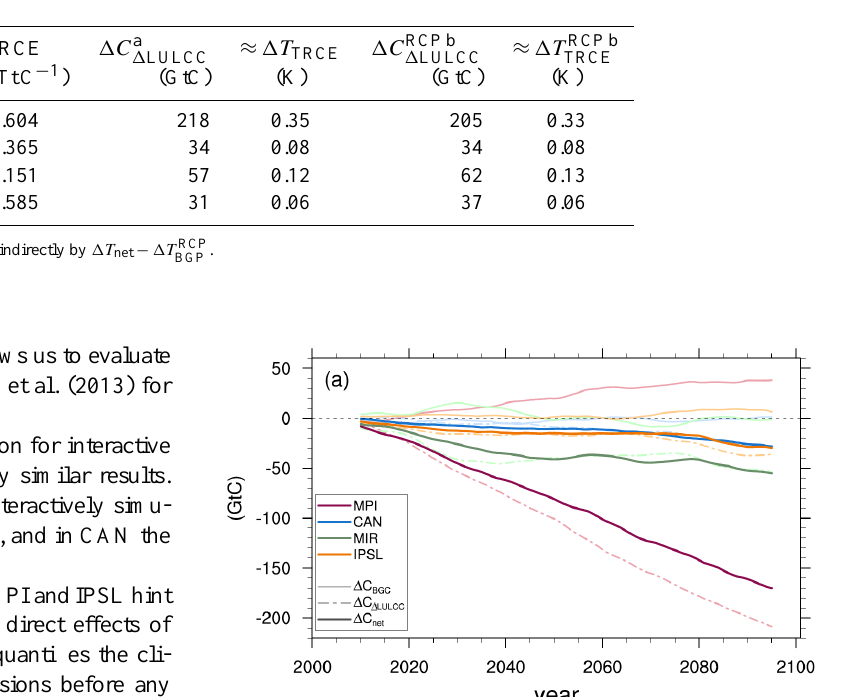
Table 5. Comparison of simulated 1T BGC (as in Table 4) to temperature changes derived from the TRCE approach (transient response of temperature to cumulative emissions; 1T TRCE Gillett et al., 2013). LULCC emissions are derived from the losses in land carbon storage ( 1C 1 LULCC ) multiplied by the TRCE values from Gillett et al. (2013) to approximate temperature changes. Results for RCP simulations ( ≈ 1T RCP ) are taken from Brovkin et al. (2013). The asterisk ( ∗ ) marks values of statistical significance ( p < 0.05). TRCE